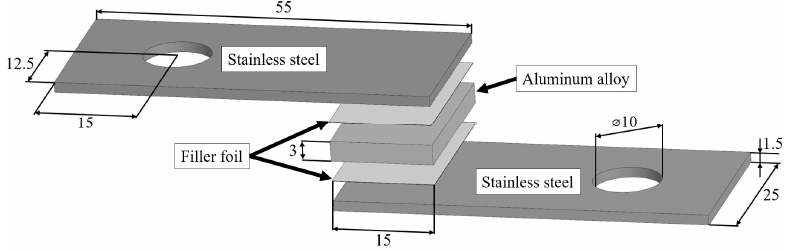
Figure 2. Brazing assembly scheme for dissimilar materials. Values are given in mm.